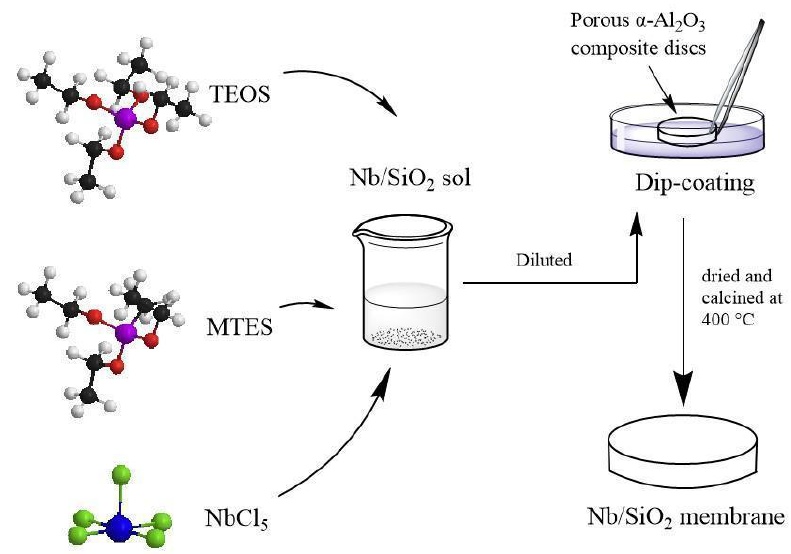
Figure 1. Schematic diagram of the fabrication of Nb/SiO 2 membranes by the sol–gel